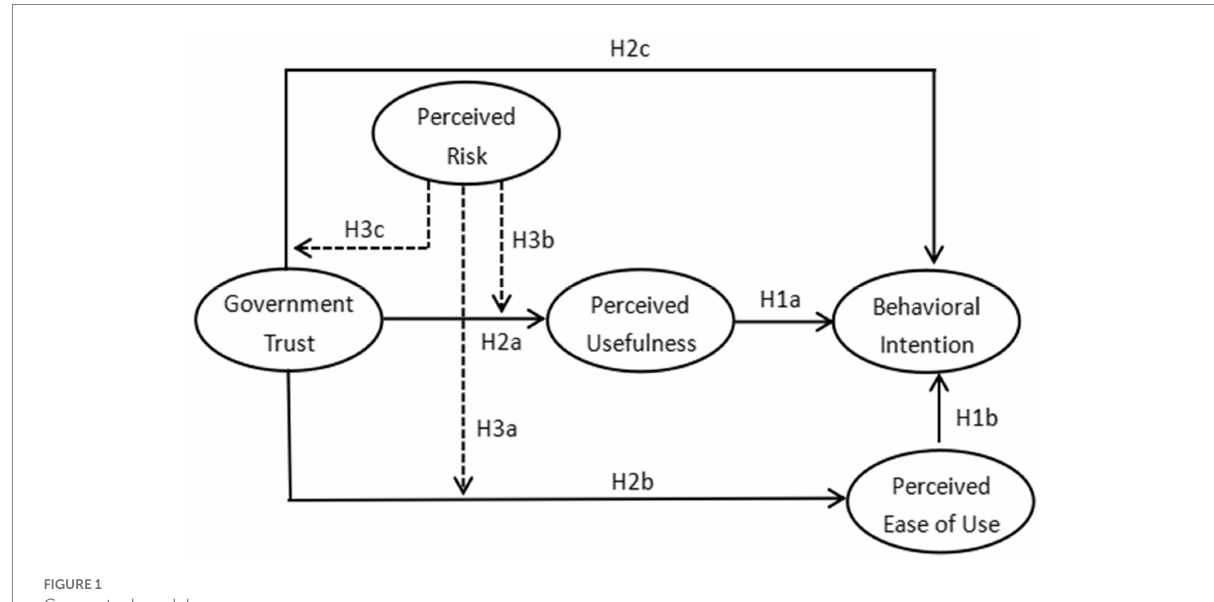
FIGURE 1 Conceptual